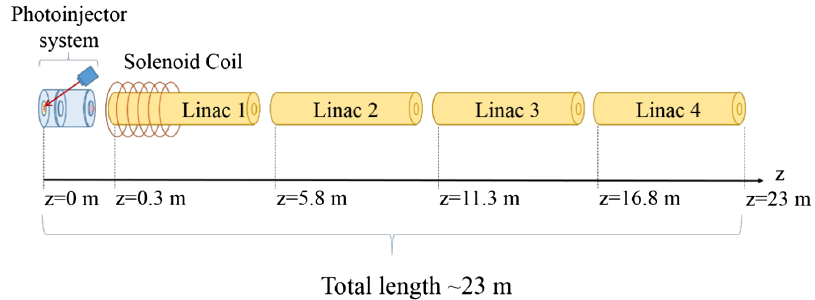
FIG. 5. The 23 m long NCRF accelerator system considered in our simulation